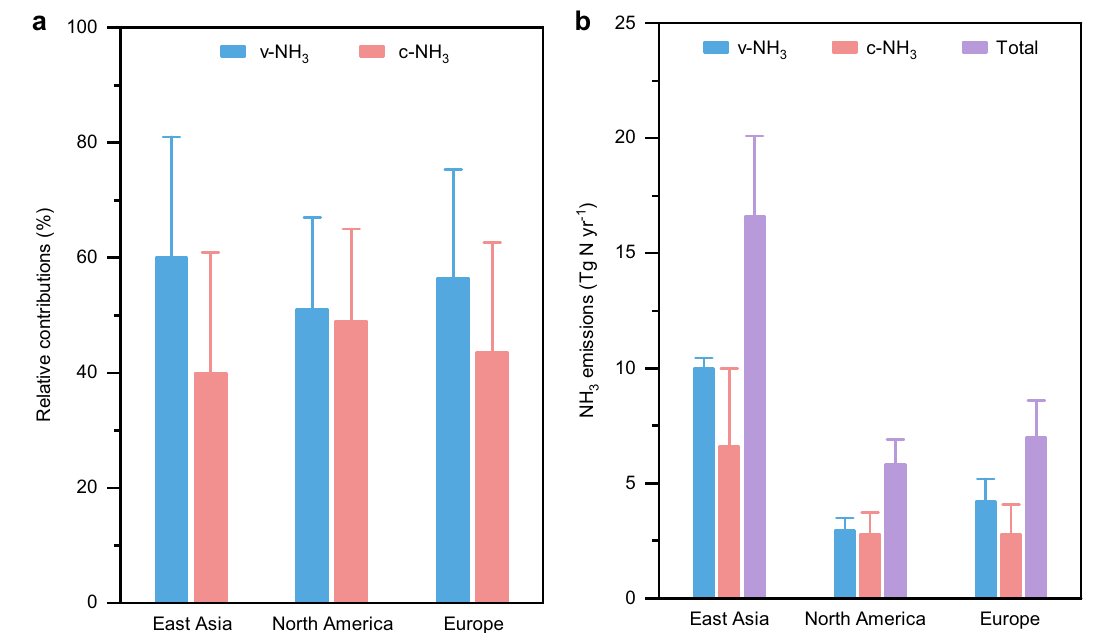
Fig.5|RelativecontributionsofvolatilizationNH 3 (v-NH 3 )andcombustion-relatedNH 3 (c-NH 3 )sources(a)andtheiremissionamounts(b). The ‘ Total ’ isthesumof v-NH 3 and c-NH 3 . Mean±SD is